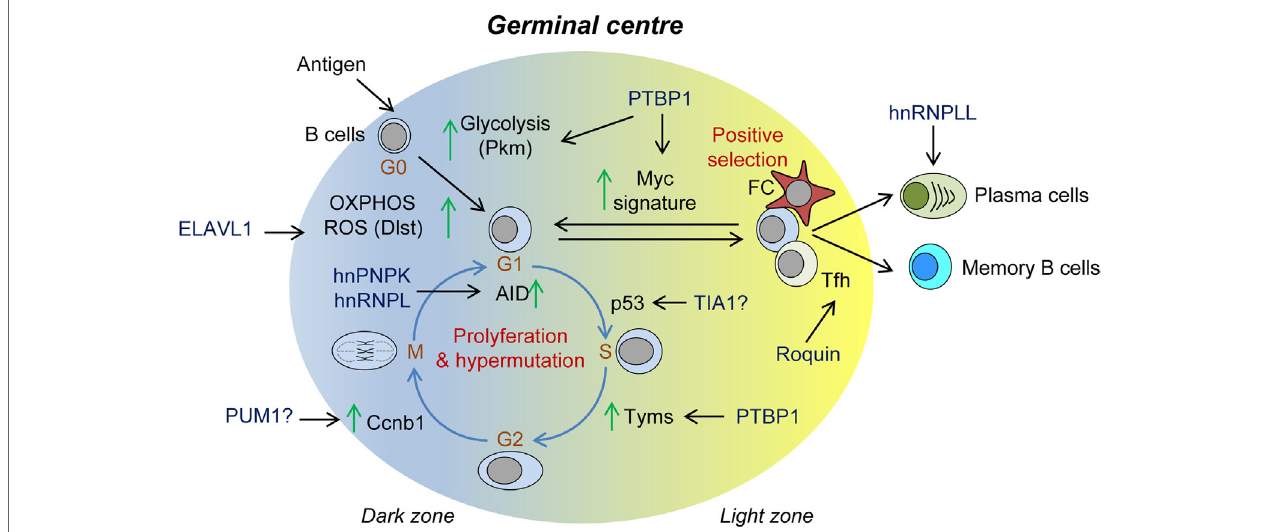
FiGURe 4 | Role of RNA-binding proteins (RBPs) in the germinal center (GC) reaction. Summary of RBPs associated with: (1) B-cell metabolic switch upon B-cell activation; (2) cell cycle progression, proliferation, and somatic Ig hypermutation in the dark zone; (3) positive GC B-cell selection and Myc-mediated re-entry into further rounds of proliferation and Ig hypermutation; and (4) terminal differentiation into plasma B cells and memory B